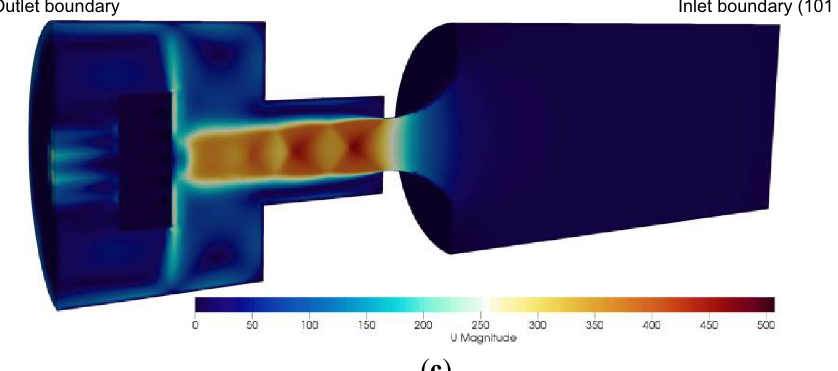
Figure 4. Overview of the experiment and numerical simulation of flow in a sonic nozzle. ( a ) Conceptual diagram of experimental apparatus. A 90° nozzle without a diffuser was installed upstream of the traverse apparatus. T r was measured from the downstream of the nozzle using the thermocouple or platinum thermometer attached to the traverse apparatus. T 0 was measured in the region where the flow velocity upstream of the nozzle was sufficiently low. The pressure gauges installed upstream and downstream of the nozzle were used to check the approximate back pressure ratio. ( b ) Simulation region. The space between the yellow-colored regions represents the 90° nozzle, and the nozzle shape is reproduced as in the experiment. ( c ) Velocity contour at 0.005 s after the start of simulation. Shock wave generation is observed downstream of the nozzle Figure 6b depicts the results of the radial traverse measurements at 1 mm downstream of the throat. The measurement points were set at intervals of 1 mm at x radial = 0–9 mm, and x radial = 0 represents the center of the nozzle throat. Each result was obtained under the constant back pressure ratio of 0.4. At x radial = 0–6 mm, the flow velocity increases as x radial increases because of the influence of the inlet curvature described above 22–26 , and RTA, and the simulation results show extremely good agreement. The throat radius of the 90° nozzle is 6.7 mm, and it is presumed that the region of x radial = 7–9 mm is outside the jet of supersonic flow; therefore, a decrease in flow velocity is confirmed. However, there is a large difference between RTA and the numerical simulation in terms of the reduction rate of flow velocity in the region outside the jet, and the experimental results indicate that the flow velocity is approximately 250 m/s even in the region considered to be outside the jet. Normally, T 0